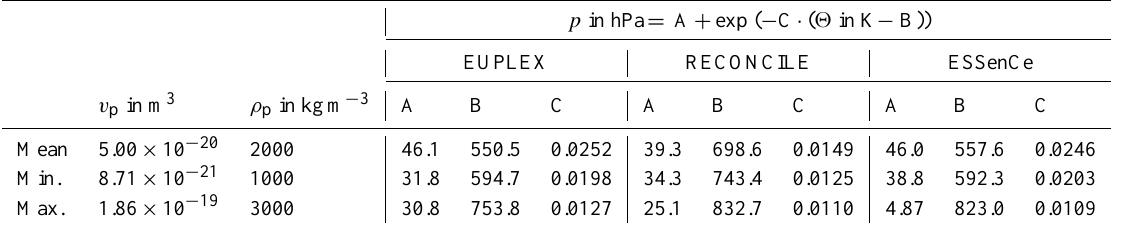
Table 2. Estimated volume ( v p ) of one refractory aerosol particle, particulate material density ( ρ p ) and parameterized (cid:50) – p relationship for the estimate of the total mass of refractory aerosol within the air volume of the polar vortex (cf. Sect.